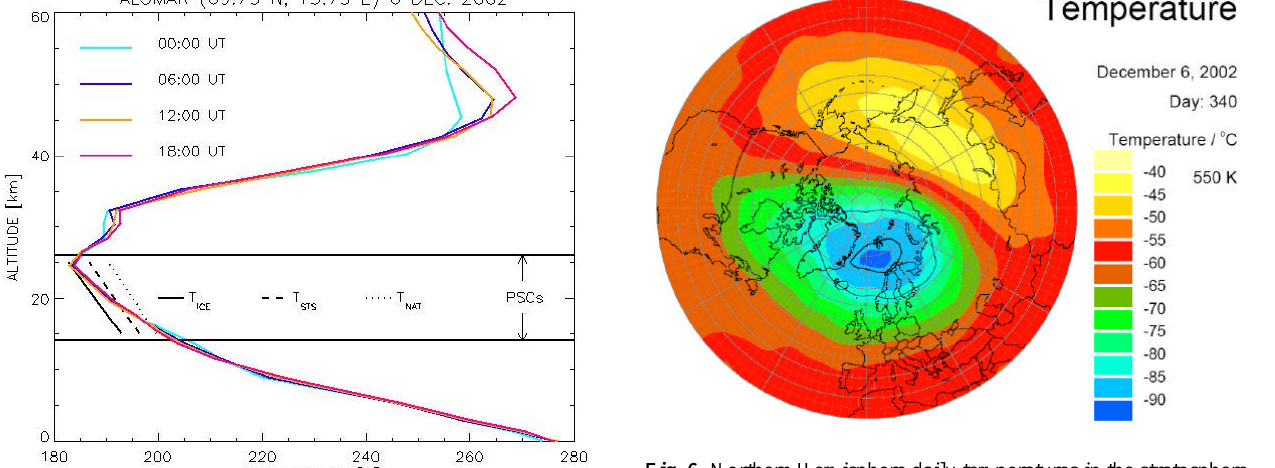
Fig. 6. Northern Hemisphere daily temperatures in the stratosphere from the European Centre for Medium Range Weather Forecast (ECMWF) at a potential temperature of 550K. Date is 6 December 2002. The profiles are colour coded according to temperature distribution.